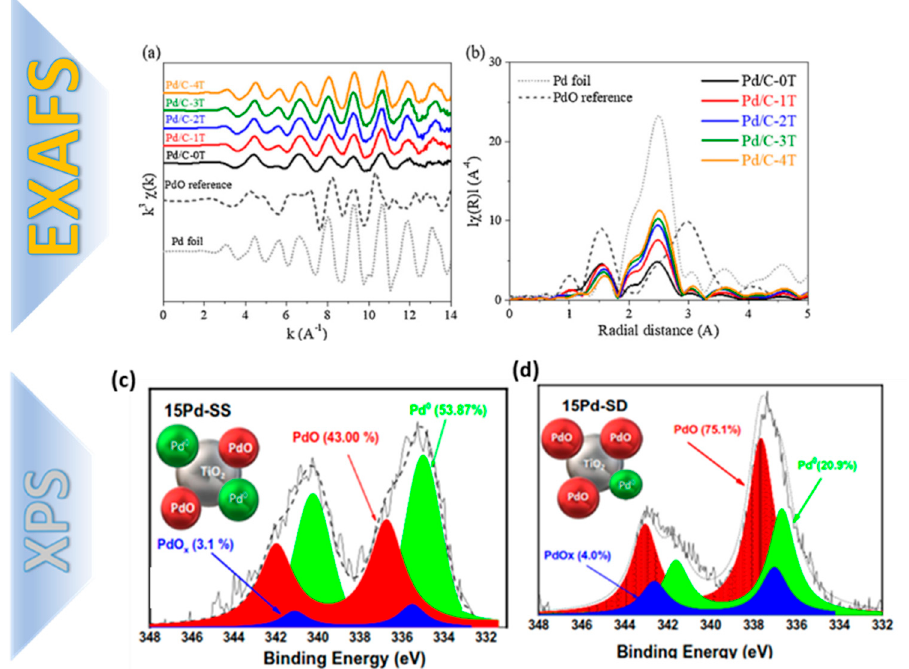
Figure 10. ( a ) EXAFS data on Pd/Al 2 O 3 catalyst, indicating the distinguishing fingerprint of Pd 0 (i.e., in a reference metal-Pd foil) vs. the PdO reference. The oxidation state of Pd was followed by recording spectra either in the QEXAFS mode (during changes of reaction conditions) or taking EXAFS spectra in the step scanning mode (after reaching steady state). Adapted from [31] with permission. ( b ) Evolution of the oxidized PdO in this sample is also reflected by the coordination number and the distance to the nearest neighbors. ( c , d ) XPS data for Pd on Pd/TiO 2 nanocatalysts prepared with different FSP protocols by in situ deposition of Pd on TiO 2 by flame spray pyrolysis technology. Enhancement of the PdO species in ( d ) is controlled by oxygen-rich FSP process. Adapted from [25] with permission.